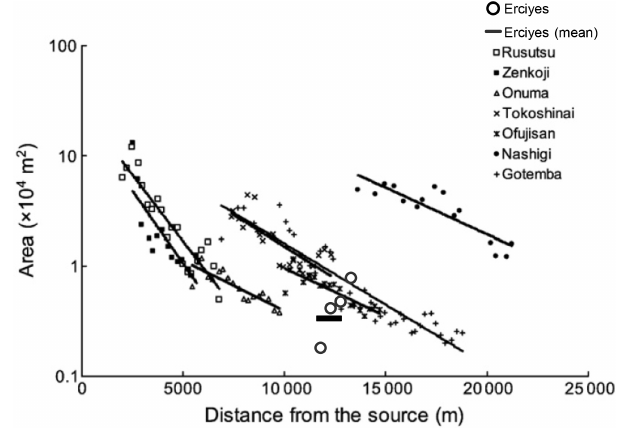
Figure 10. Relationship between the distance from the source and hummock size for the avalanche at Mt. Erciyes and those previously reported by Yoshida et al. (2012). The white circles indicate the mean area of hummock polygons summarized for each 500m bin of the distance, while the black horizontal bar shows the average areas for all the hummocks in Erciyes. Solid lines are linear regressions for each avalanche previously